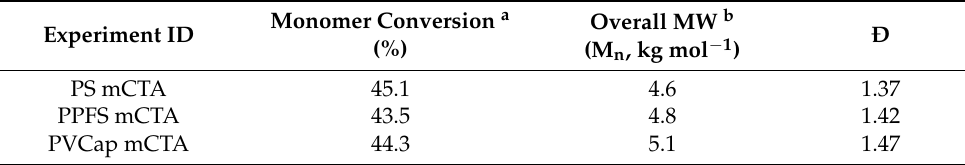
Table 3. Identification of the macro-CTAs (mCTA)